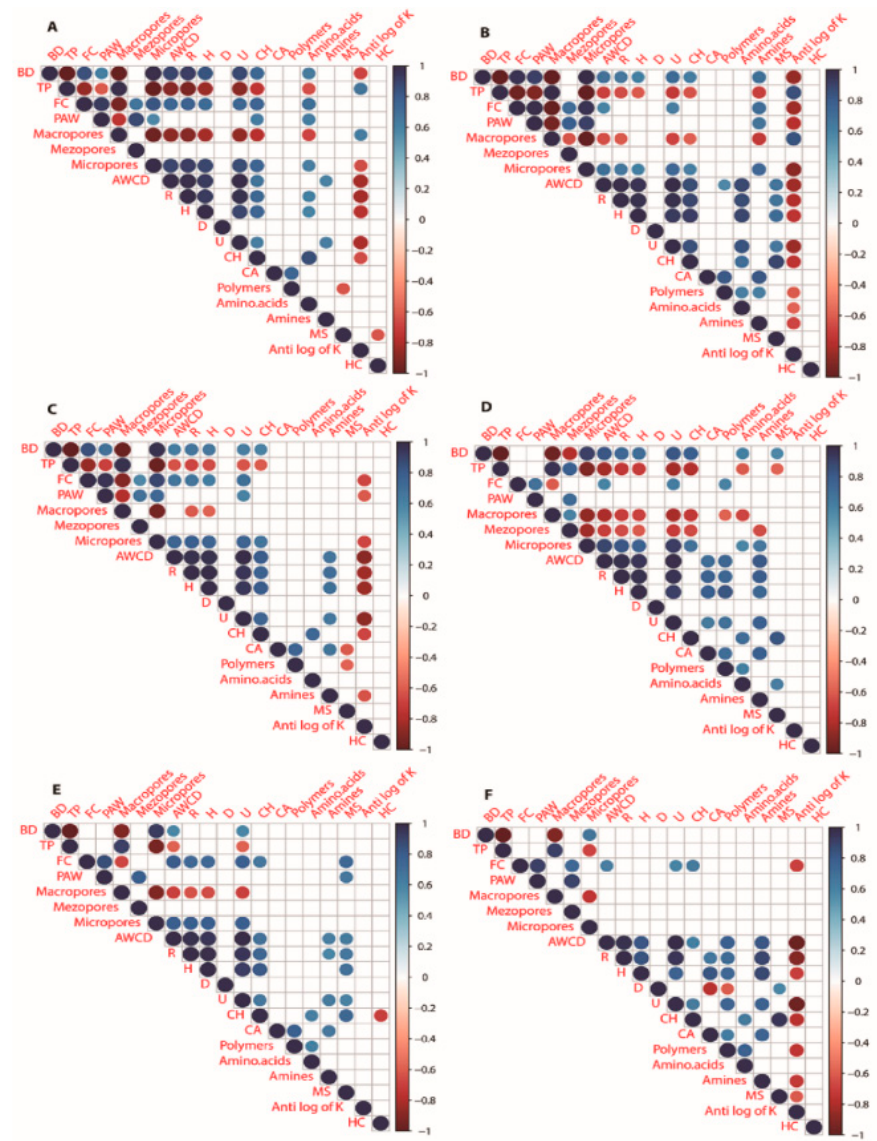
Figure 8. Heatmap correlations under different treatments ( A ) B0N0 (without biochar and N fertilization); ( B ) B0N1 (Without Biochar and 160 kg·ha −1 N); ( C ) B0N2 (Without Biochar and 120 kg·ha −1 N fertilization); ( D ); B1N0 (Biochar 25 t·ha -1 only); ( E ) B1N1 (Biochar 25 t·ha -1 and 120 kg·ha −1 N); ( F ) B1N2 (Biochar 25 t·ha −1 , 160 kg·ha −1 N) for bulk density (BD), total porosity (TP), field capacity (FC), plant-available water (PAW), average well color development (AWCD), richness (R), the Shannon index (H), the Simpson index (D), the Mclntosh index (U), carbohydrates (CH),